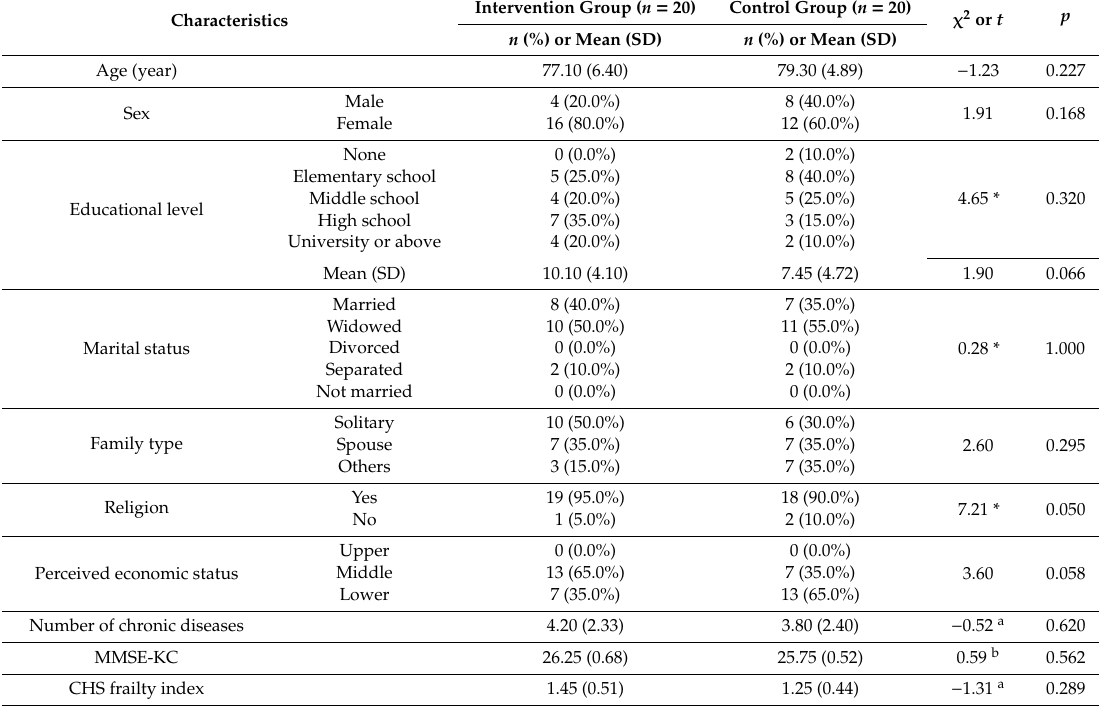
Table 1. Homogeneity test of demographic, clinical characteristics, and outcome